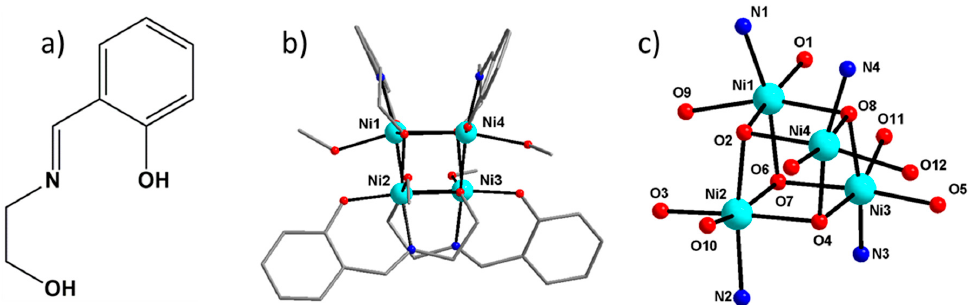
Figure 1. ( a ) salicylidene-2-ethanolamine (H 2 L); ( b ) molecular structure of [Ni 4 ] cluster; and ( c ) the view of the cubane core with labels.